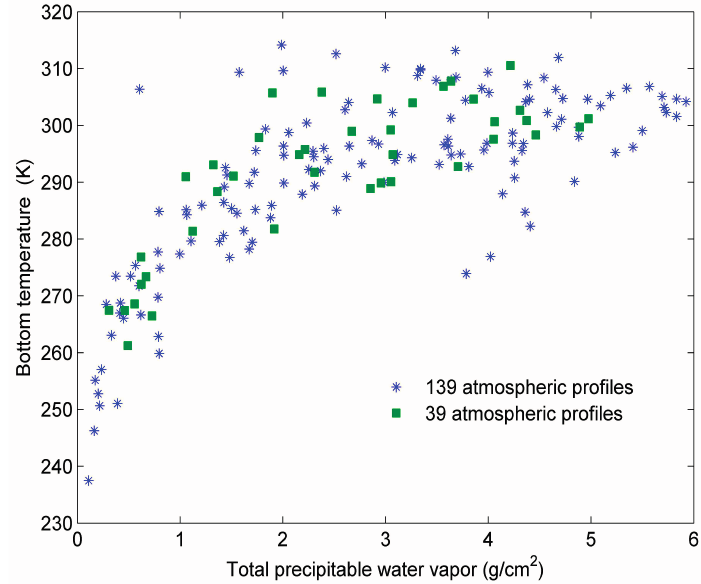
Figure 1. The bottom temperatures as a function of the total precipitable water vapour for the 139 atmospheric profiles and other 39 atmospheric